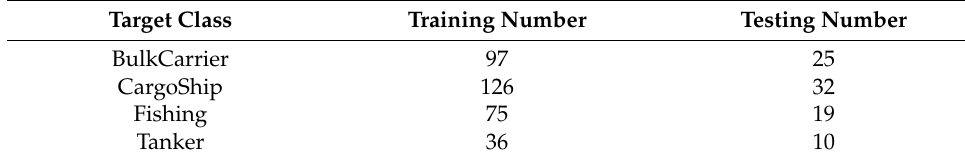
Figure 5. Example images from the MSTAR dataset. Figure 6. Example images from the FUSAR-Ship dataset.